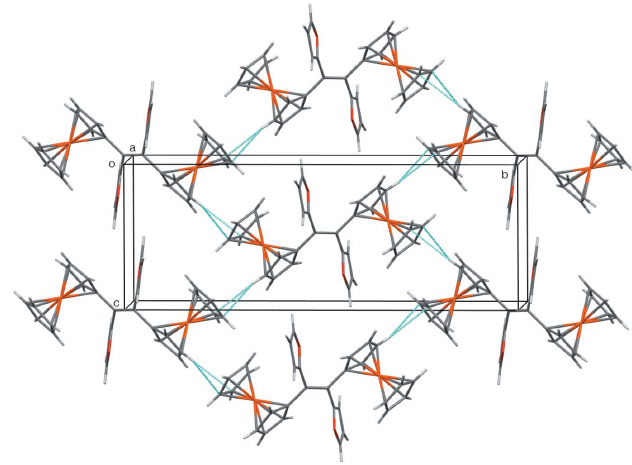
Figure 2 The sheets of molecules lying parallel to the (101) plane formed by the C8—H (cid:3)(cid:3)(cid:3) (cid:2) interactions.